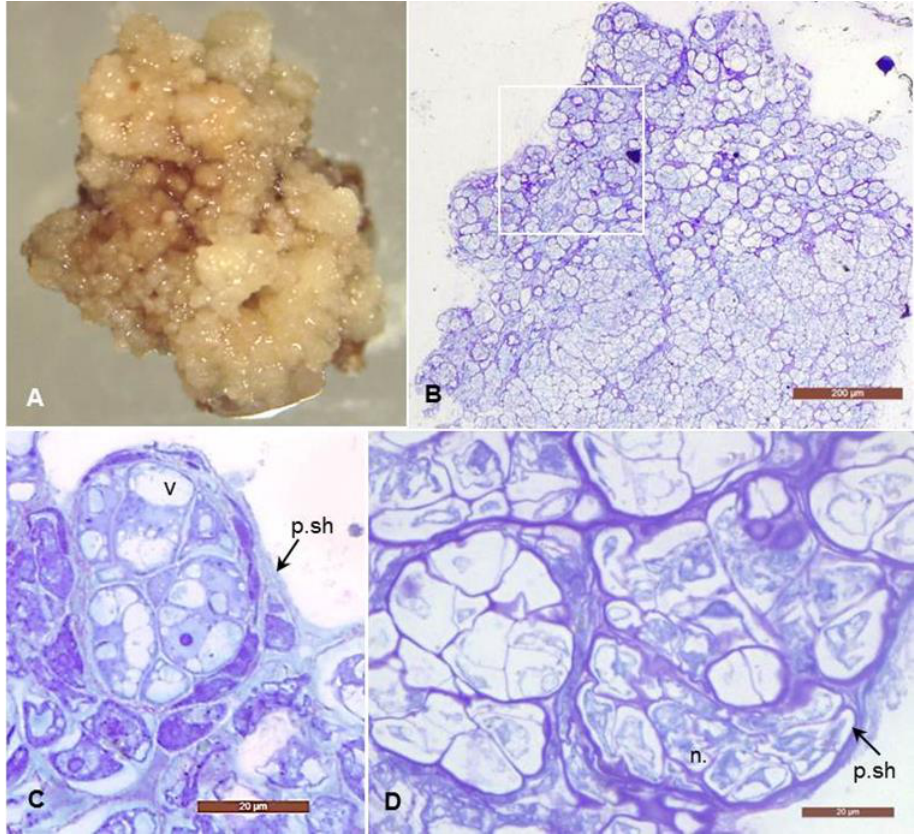
Figure 2. ( A ) Morphology of the degenerative embryogenic callus (DEC) of Phoenix dactylifera cv. Barhee showed the compacted yellow firm masses. ( B ) A semi-thin section of the DEC illustrated the occurrence of cellular groups aggregated together forming disorganized vacuolated masses with distinguished fragmentation lines. ( C ) High magnification for one cellular group (early globular stage) showed more vacuolated cells, rich in phenolic compounds, exhibiting a cessation in cell division and surrounded by very thick walls, i.e. , polysaccharide sheath (p.sh). ( D ) Degenerated cellular groups caused necrosis (n.) and acquired brown color in the DEC masses.